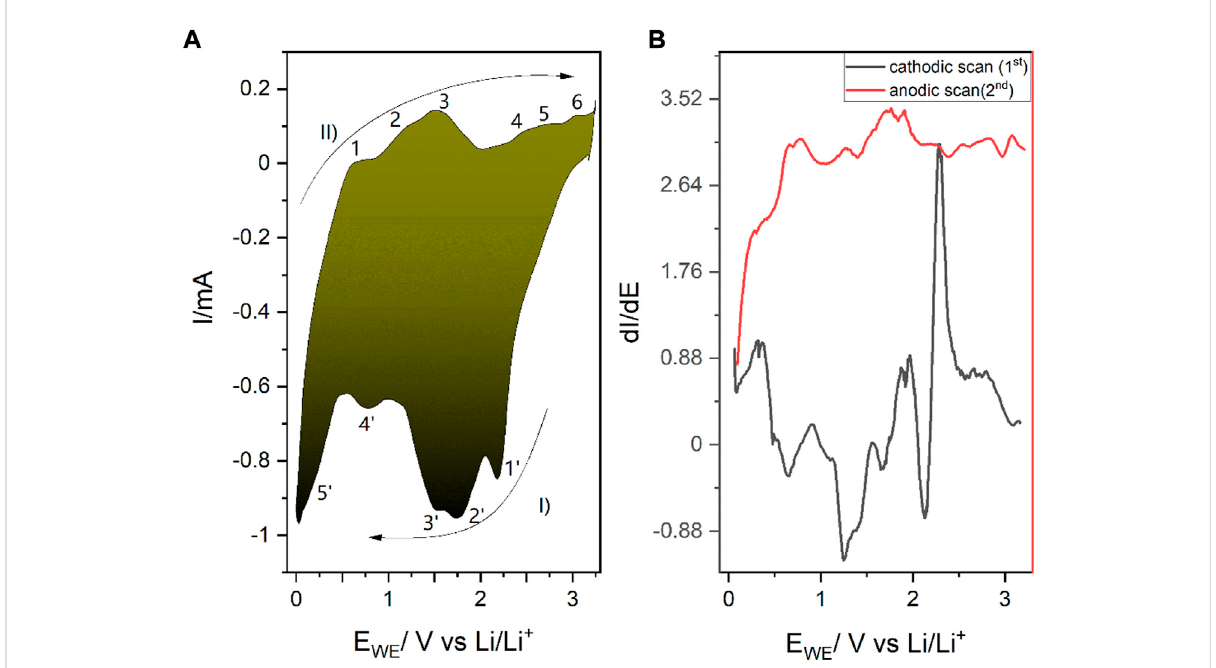
FIGURE 3 (A) Electrochemical cyclic voltammetry scans of the 2D SnS 2 with 0.01 mV/s scan rate during Li + (de)intercalation/alloying. I) refers to the forward and II) to the reverse scan, while the consecutive numbers correspond to the reactions listed in Table 1. (B) Corresponding dI/dE plot for a more pronounced representation of the electrochemical peaks. The observed transitions are gathered in Table 1 and discussed in the text. The cathodic scan was performed prior to the anodic